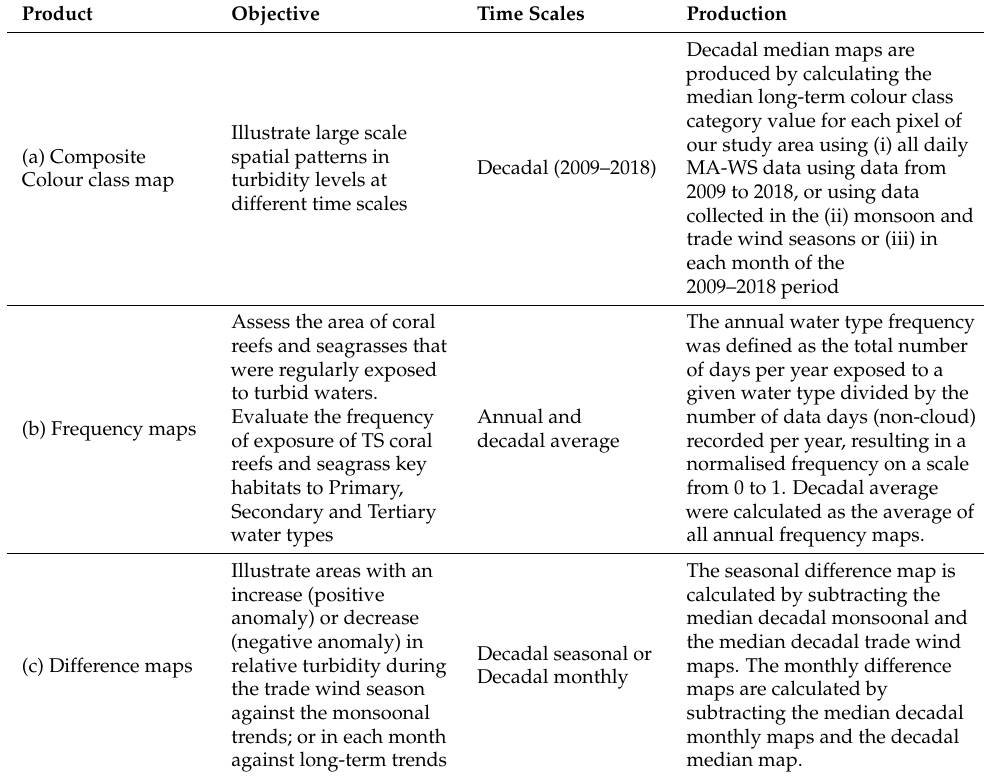
Table 3. Satellite products used to describe turbid waters and habitat exposure in the Gulf of Papua-TS region. All products have been computed using daily MA-WS water type